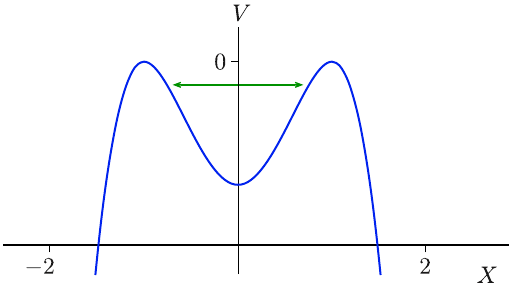
Figure A.2: Sketch of the potential V ( X ) in Eq. (A.10). The green arrow schemati- cally indicates an oscillating solution. Using the mapping between X ( T ) and ϕ ( x )